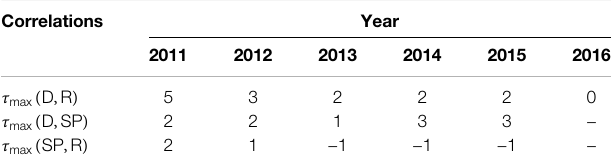
TABLE2| Thetimelagsfrom2011until2016.Foreachyearfrom2011until2016, we compute the correlation between the number of reported dengue cases (D), positive SPs and the rainfall (R) for different time lags τ . The value of τ = 1 corresponds to one fortnight. We show the time lags that correspond to the largest correlation in the corresponding year. There is no SP data available for